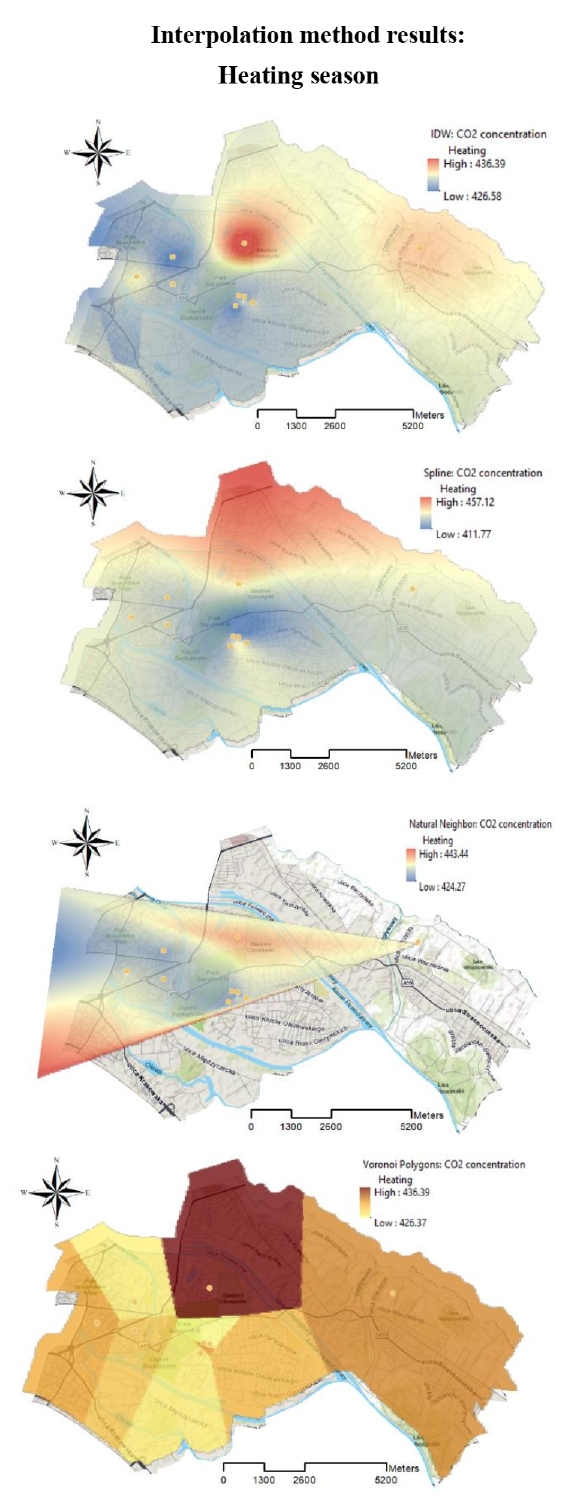
Figure 6. Interpolated surfaces of CO 2 distribution in the Heating season. 3-D view in ArcScene obtained for selected interpolation techniques (top to bottom): Inverse Distance Weighting (IDW), Spline, Natural Neighbour (NB) interpolation, Voronoi (Thiessen)